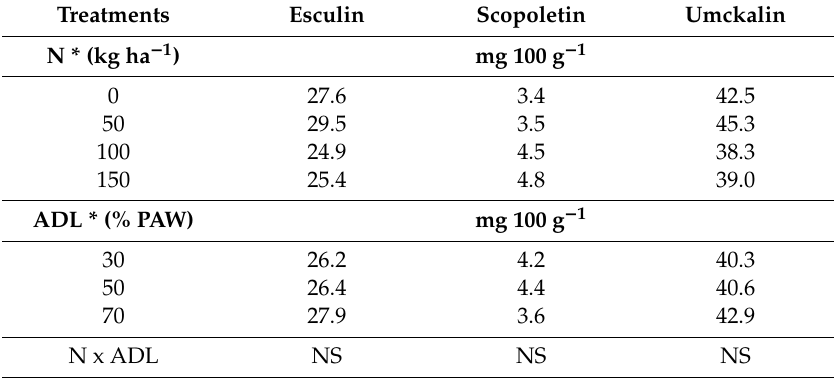
Table 3. Esculin, scopoletin, and umckalin content of Pelargonium sidoides roots as a ff ected by nitrogen and water